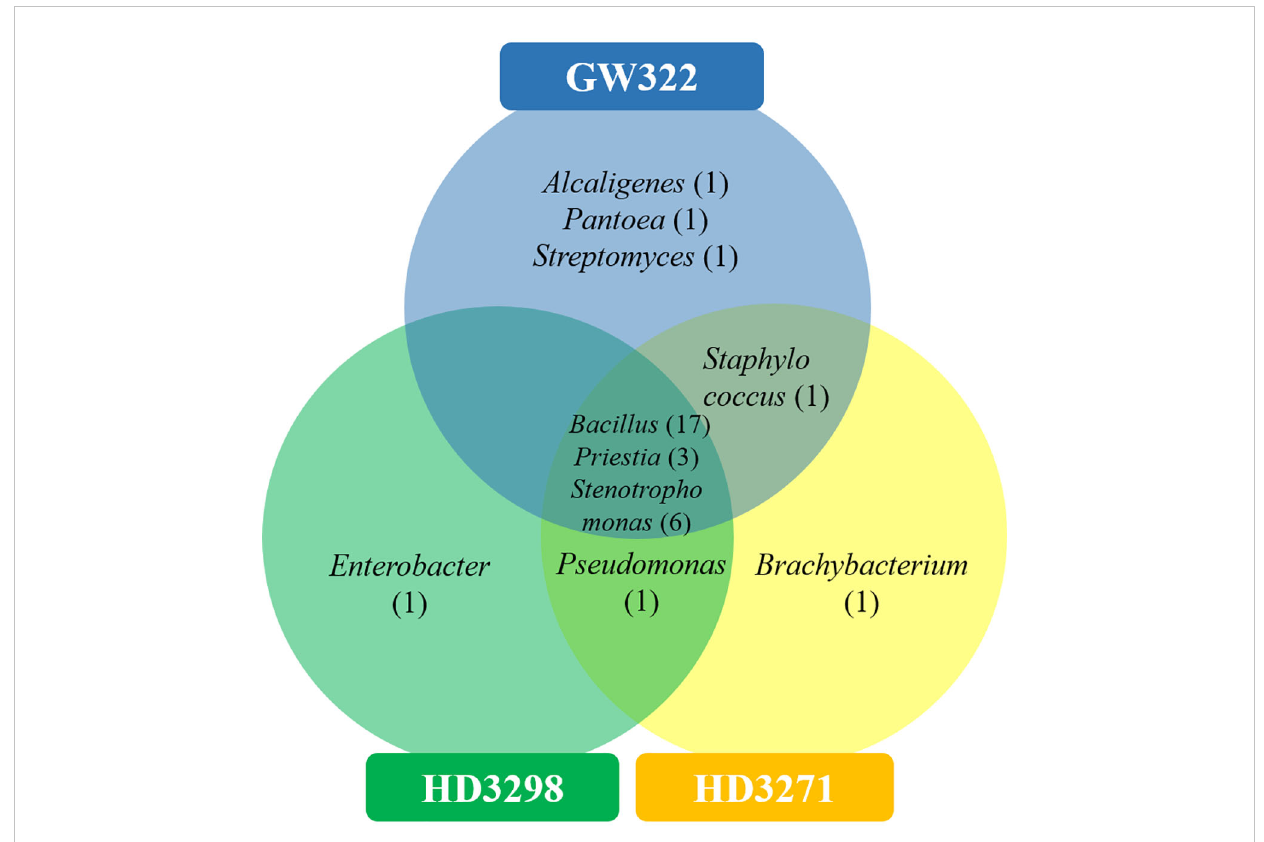
FIGURE 9 Venn diagram showing the genus-level distribution of culturable WSEB isolates from heat S (GW322) and heat T (HD3298 and HD3271) wheat